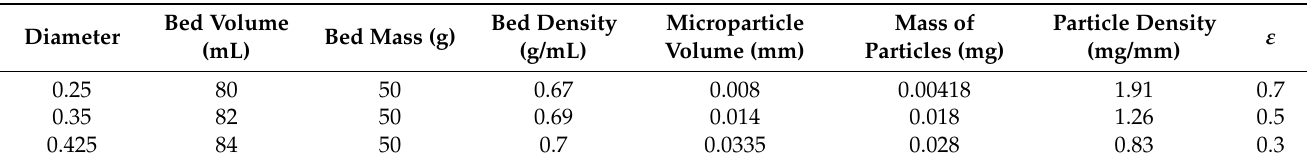
Figure 10. Treatment with EC experiments of 400 mg/L and 100 mg/L. Table 6. Parameters of densities of the system of